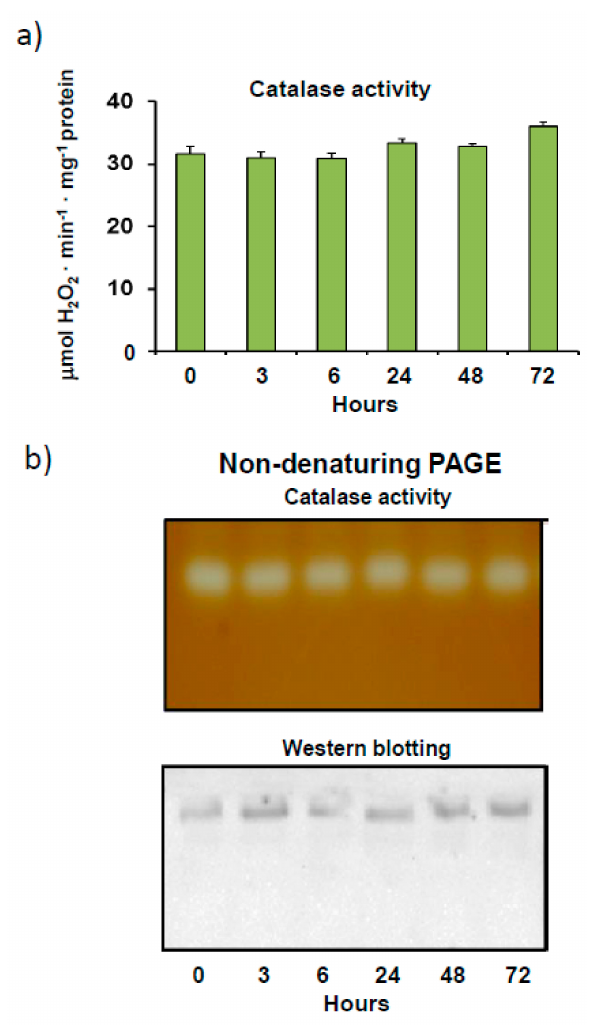
Figure 1. Catalase activity and protein content as a function of time in crude extracts from sweet pepper fruits. ( a ) Total enzyme activity. Samples were incubated at 4 ◦ C for 0 to 72 h and then analyzed for catalase activity. Results are means ± SEM of samples from at least three di ff erent experiments, while the ANOVA test ( p < 0.05) was used for statistical analysis. ( b ) Activity and protein level of the catalase isoenzyme as a function of time in pepper fruit. Prior to electrophoresis, samples were incubated at 4 ◦ C for 0 to 72 h. Native electrophoresis was performed in 6% acrylamide gels for these assays. Green pepper fruit samples (20 µ g protein) were used for catalase activity staining in gels. For western blot assays, pepper fruit samples (20 µ g protein) were loaded onto gels and catalase was detected using an antibody against Arabidopsis thaliana catalase (1:5000 dilution). Shown pictures are representative of the non-denaturing PAGE and western blotting assays from at least three independent